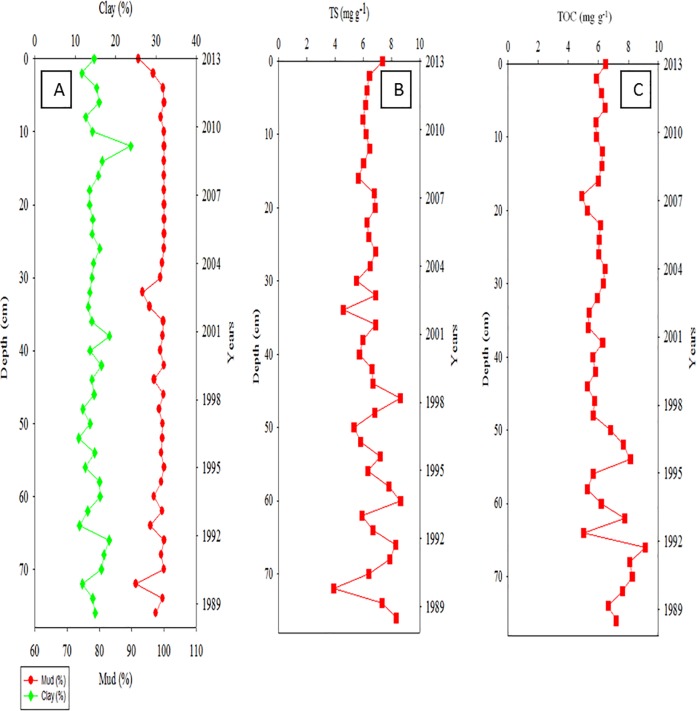
Distributions of fine particle (clay & mud, A), total sulfur (TS, B), and total carbon (TOC, C) in Core Ks3 sediments.